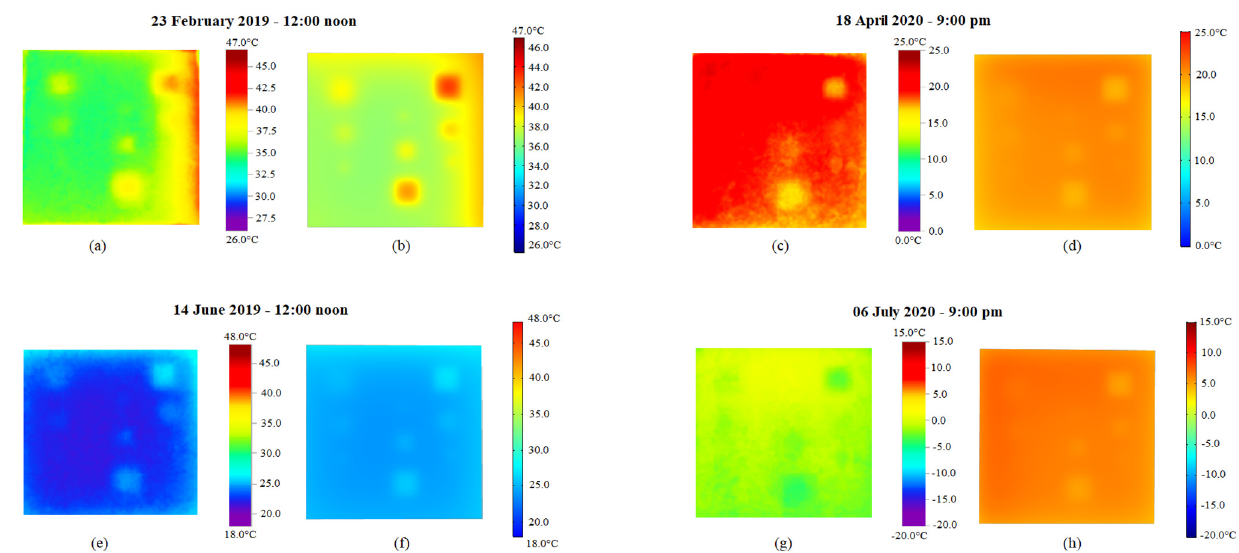
Figure 4. Comparison between: ( a , c , e , g ) Thermograms obtained from the IRT experiment; ( b , d , f , h ) Thermograms obtained from the FEM numerical model.